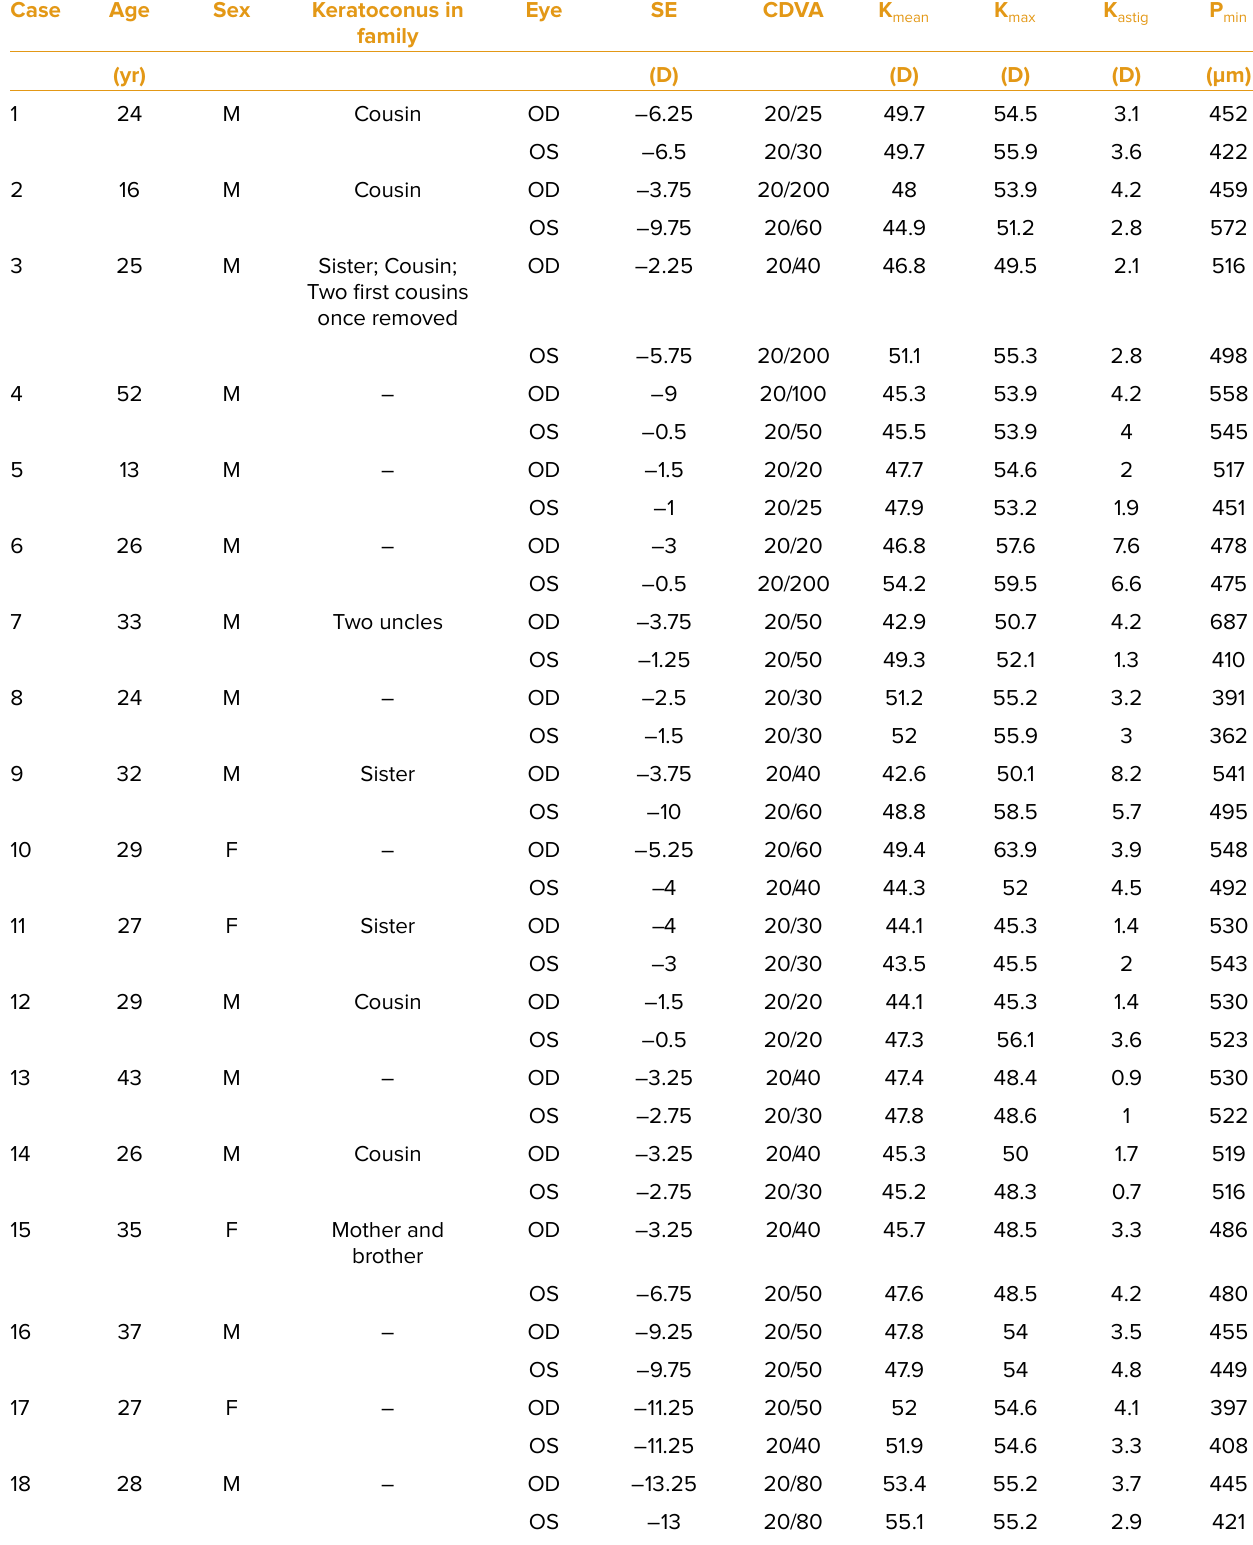
Table 1. Demographic, refractive, and keratometric characteristics of cases Case